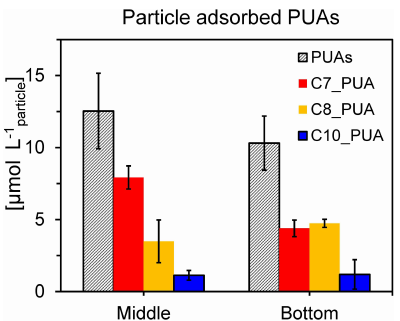
Figure 6. Concentrations of particle-adsorbed PUAs (in micro- moles per liter particle) in the middle (12m) and the bottom (25m) waters of station Y1 during June 2019. Three different PUA compo- nents are also shown, including heptadienal (C7_PUA), octadienal (C8_PUA), and decadienal (C10_PUA). Error bars are the standard